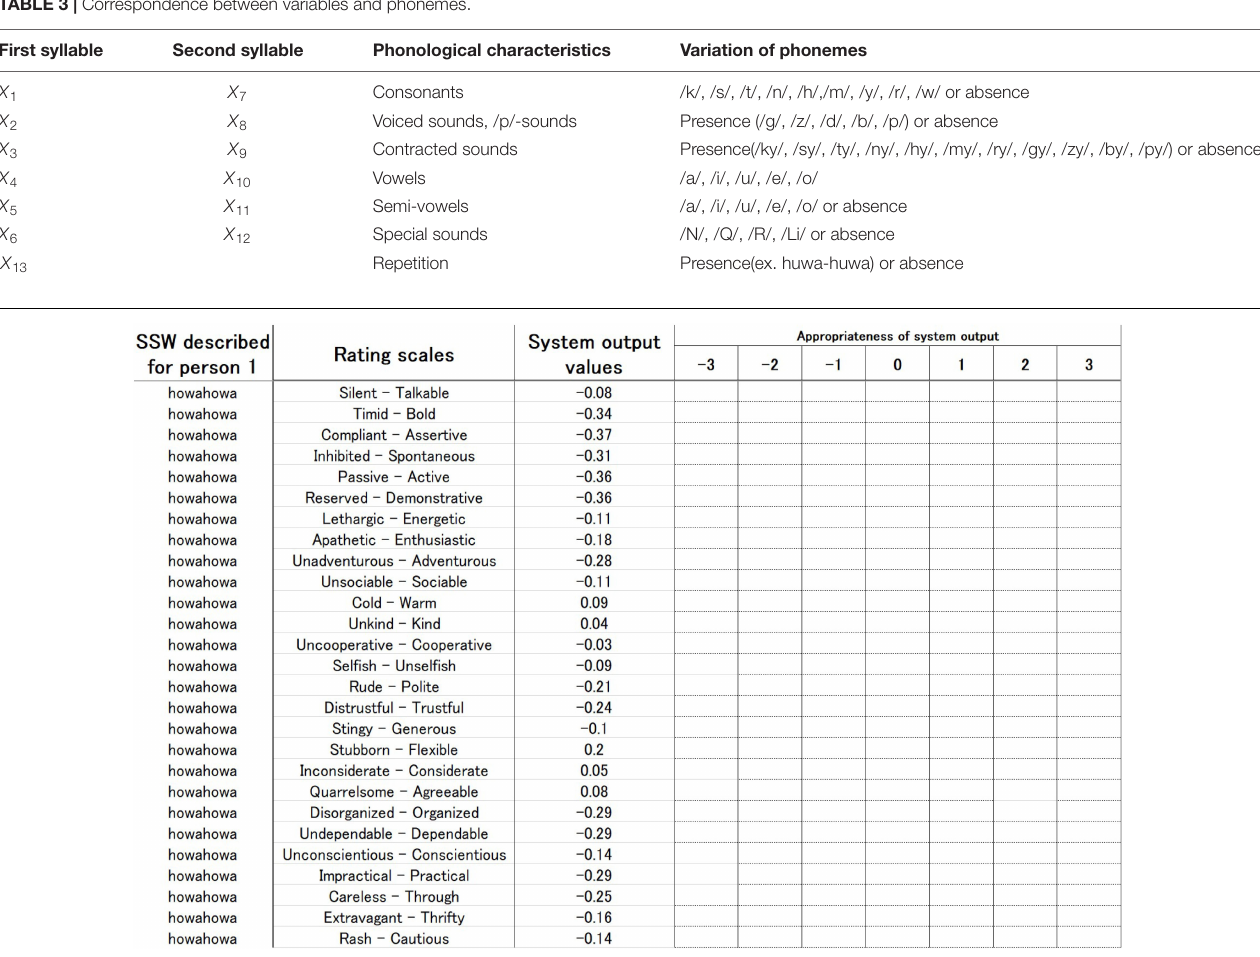
TABLE 3 | Correspondence between variables and phonemes.